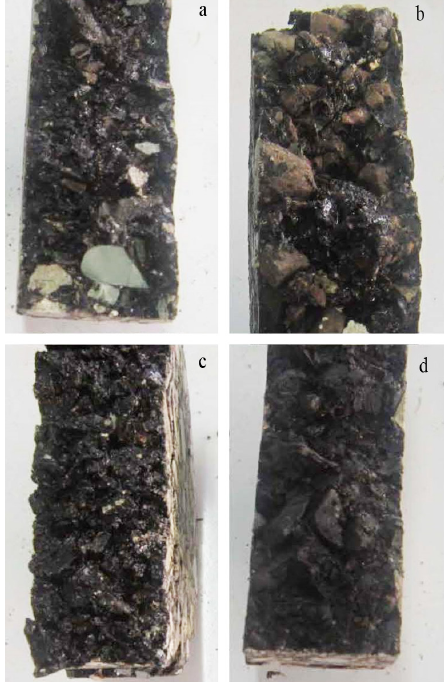
Fig. 10. Broken faces of the split samples: a) for dry granite sample at 4.4 ºC; b) for moisture conditioned granite sample at 4.4 ºC; c) for dry granite sample at 21.1 ºC; d) for moisture conditioned granite sample at 21.1